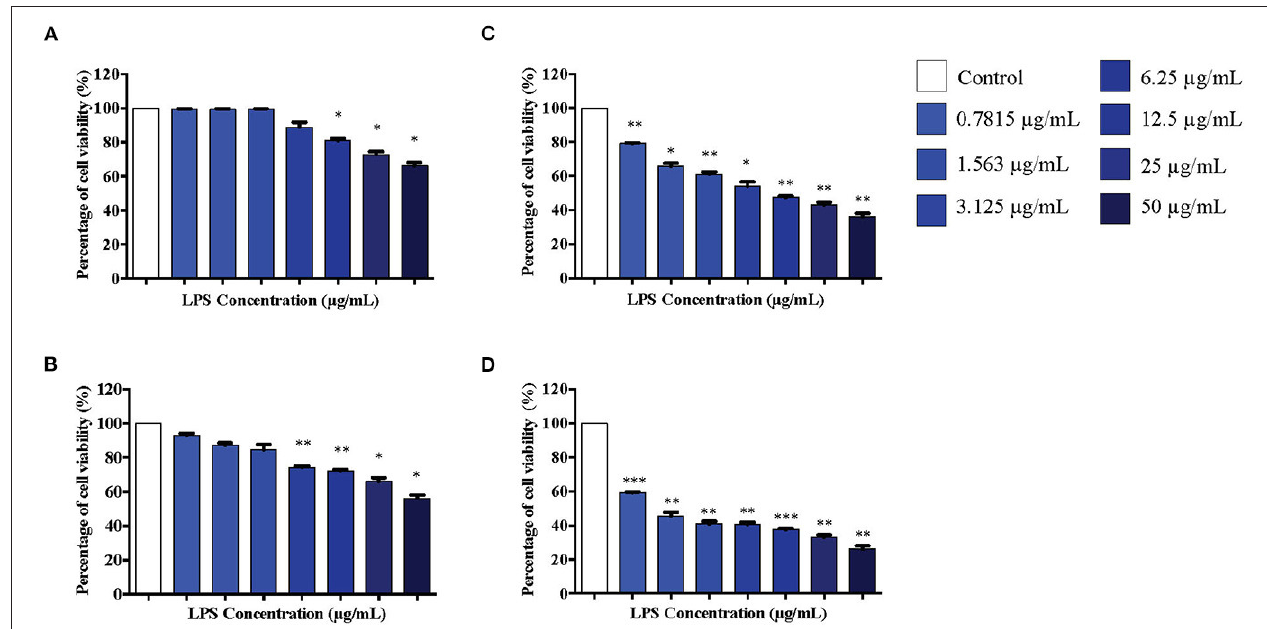
FIGURE 2 | The differentiated PC12 cells were exposed to 50, 25, 12.5, 6.25, 3.125, 1.563, and 0.7815 µ g/mL LPS for (A) . 12, (B) . 24, (C) . 48, and (D) . 72h. Cell viability was determined by MTT assay. Bars represent mean data ± S.E.M from three independent experiments. Data were analyzed using one-way ANOVA, followed by a Bonferroni post-hoc test. Percentage of cell viability of LPS-stimulated cells was compared to control. * p < 0.05, ** p < 0.01, *** p < 0.001 considered to be statistically significant.